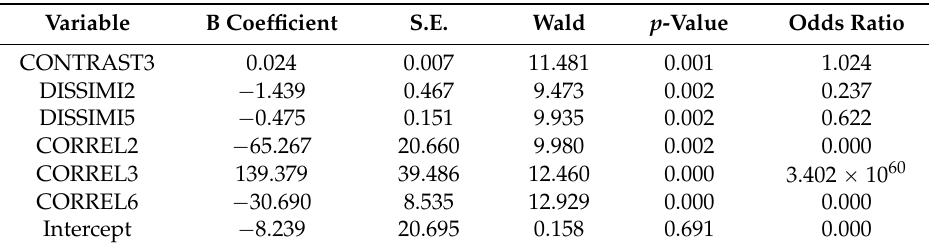
Table 4. Feature selection results of OBIA using LR